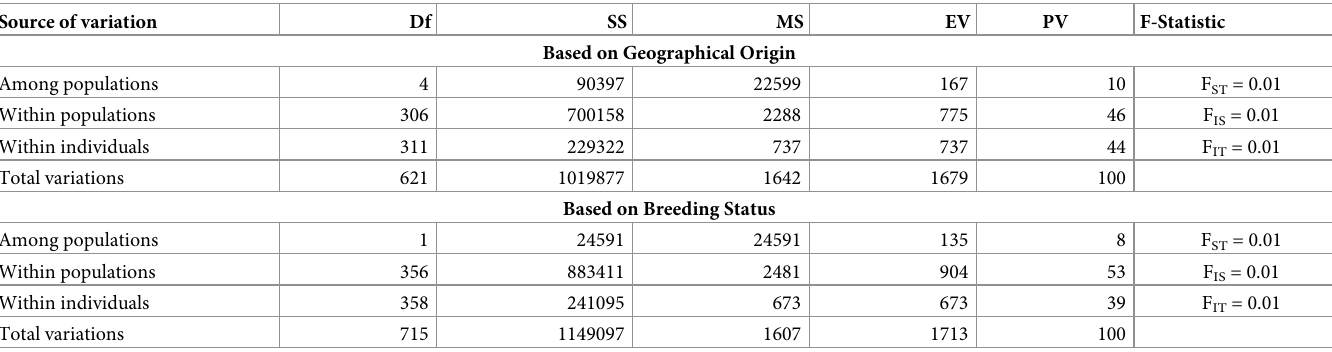
Table 2. Analysis of molecular variance among and within cowpea